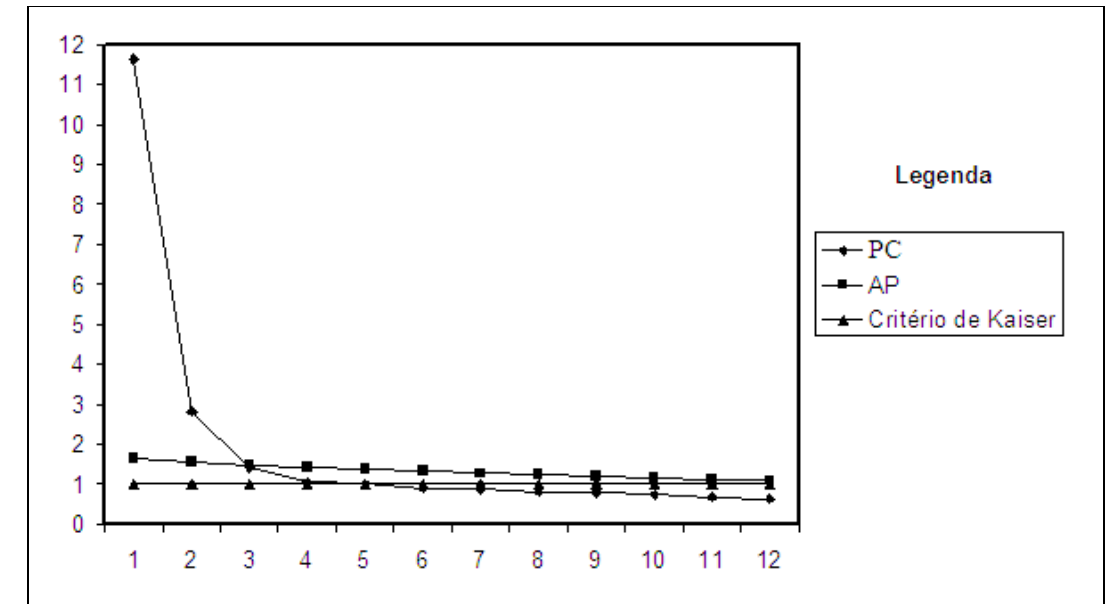
Figura 1 . Distribuição gráfica dos valores